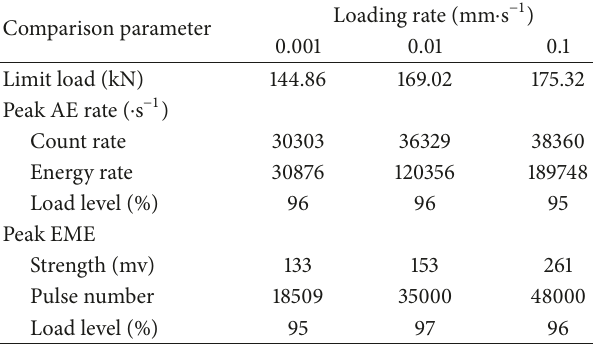
Table 1: Characteristics of AE and